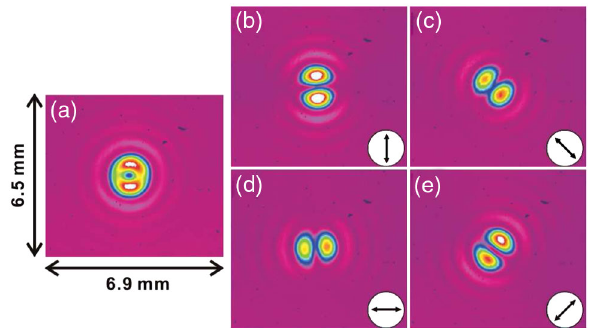
with (b)–(e) a polarizer. Arrows represent polarization direc- tions. TEM01 and TEM10 modes appear through the linear polarizer, indicating that radial polarization is generated with a nematic-liquid-crystal radial polarization